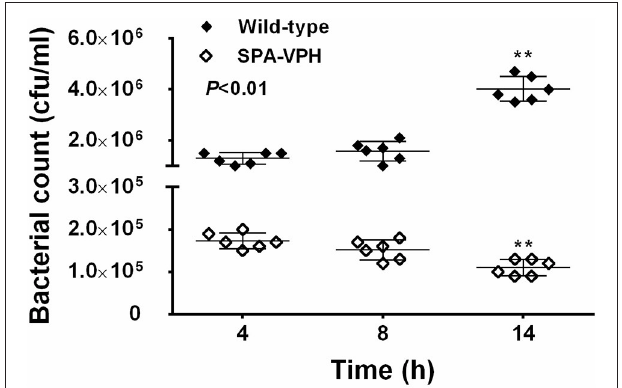
FIGURE 2 | Intracellular survival of Salmonella enterica serovar Paratyphi A wild-type and SPA-VPH in THP-1 cells. Fresh cultures of tested bacteria, suspended in PBS, were inoculated to the differentiated THP-1 cells at a ratio of 10:1. After 2h of incubation, extracellular bacteria were eliminated in the presence of 100 µ g/ml gentamicin for 2h. At the indicated time postinoculation, intracellular bacteria were released by addition of 0.5% Trition X-100 and quantitated by culture and colony counting. (** P <